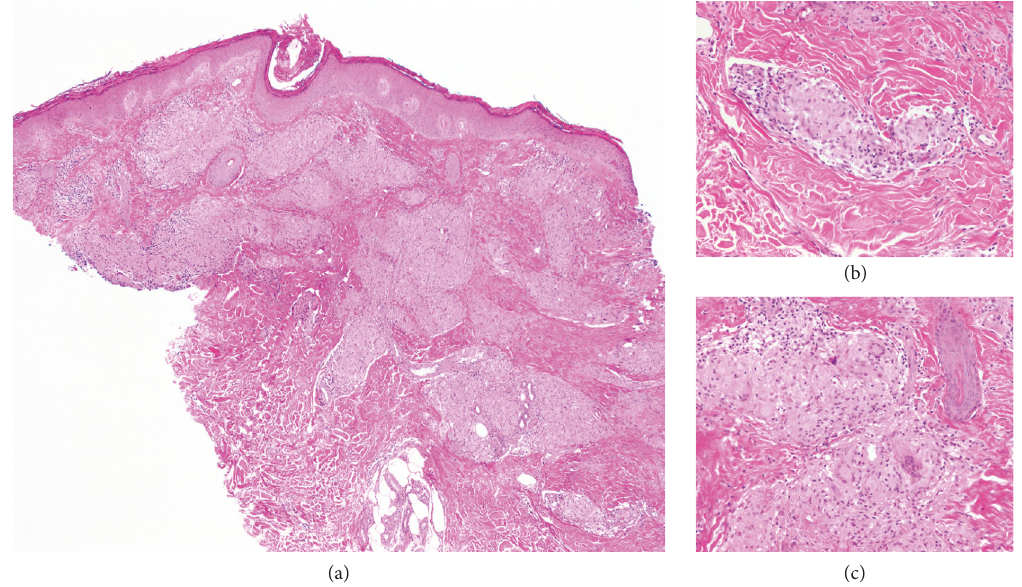
Figure 2: (a, b and c) Histology of left knee lesion showing a sarcoidal-type granulomatous reaction. (a) Much of the reticular dermis is occupied by a granulomatous infiltrate (hematoxylin and eosin staining, original magnification x40). (b and c) Individual granulomas are sarcoidal in type, i.e., non-necrotising with a minimal associated lymphocytic infiltrate (so-called “naked” granulomas) (hematoxylin and eosin staining, original magnification